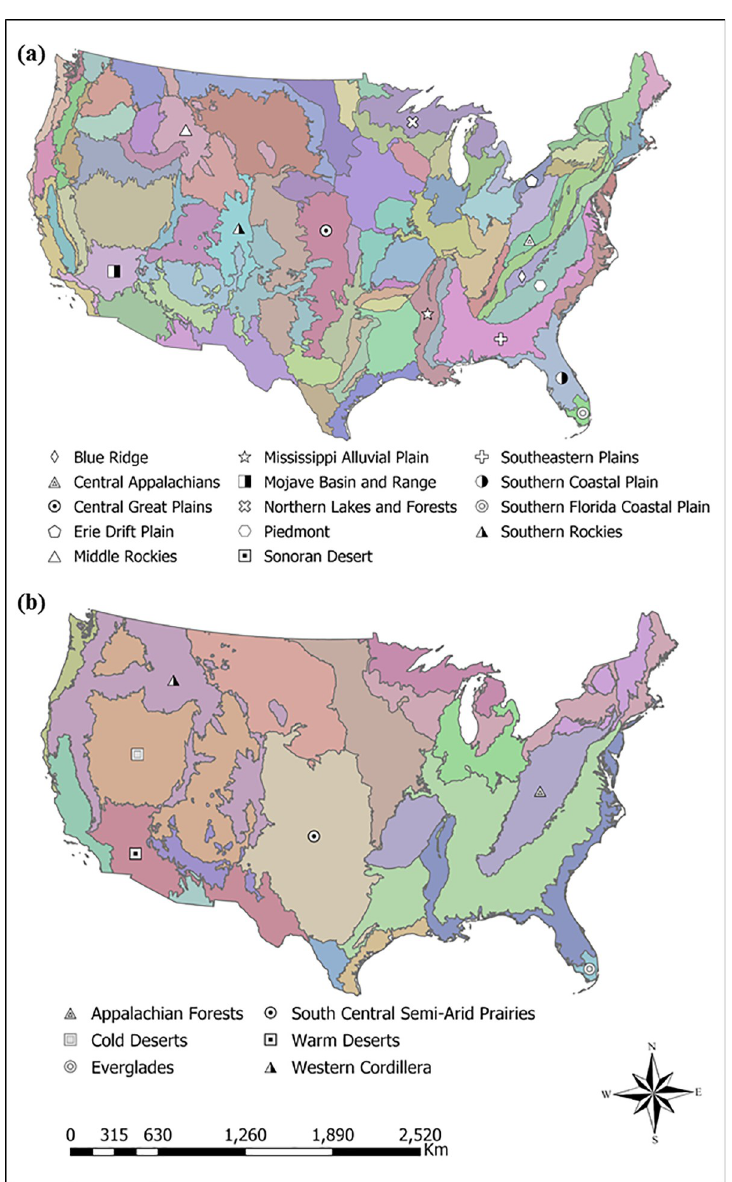
Fig 2. Level III and II Ecoregions of the United States. ( a ) Level III and ( b ) level II ecoregions of the United States as defined by the U.S. Environmental Protection Agency. Ecoregions labeled in the figure are referenced in the text.